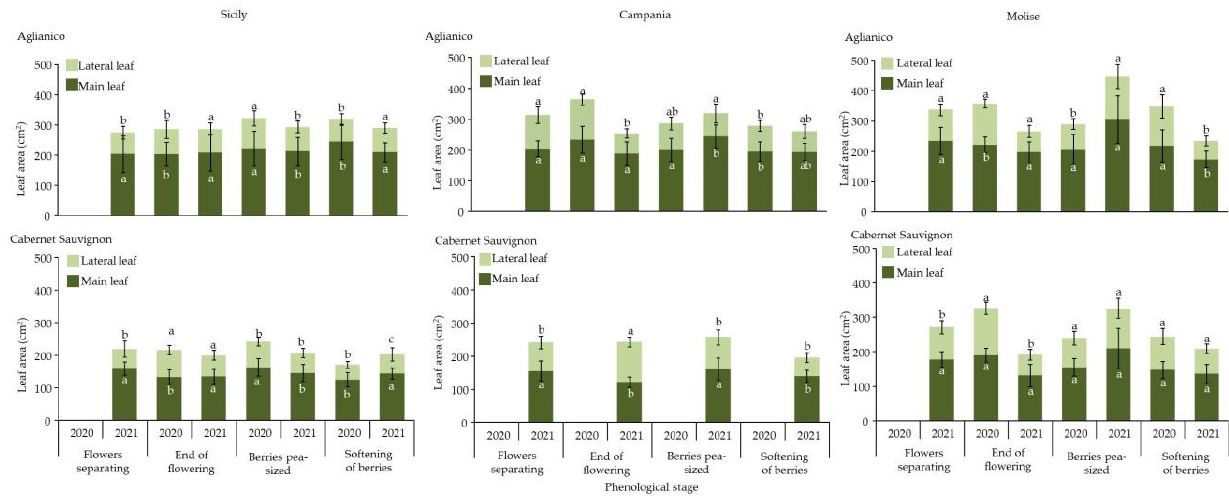
Figure 4. Leaf areas from the main and lateral shoots in each of two cultivars, Aglianico (AGL) and Cabernet Sauvignon (CAB), grown at three different sites, Molise (MOL), Campania (CAM), and Sicily (SIC). Measurements were made at the phenological stages BBCH57 (only second year) flowers separating, BBCH69 end of flowering, BBCH75 berries pea-sized, and BBCH85 softening of berries (bars indicate one standard deviation), based on Tukey’s HSD test within sites and years. Concerning the total leaf area per vine (Figure 5), AGL in MOL, during the first year at each phonological stage, showed significantly higher values. During the second year, except at the pea-sized berries stage, the vine behaviour was similar between CAM and MOL. In SIC, no differences were recorded between the different stages. For CAB, the trends for total leaf area per vine were similar to those for AGL.